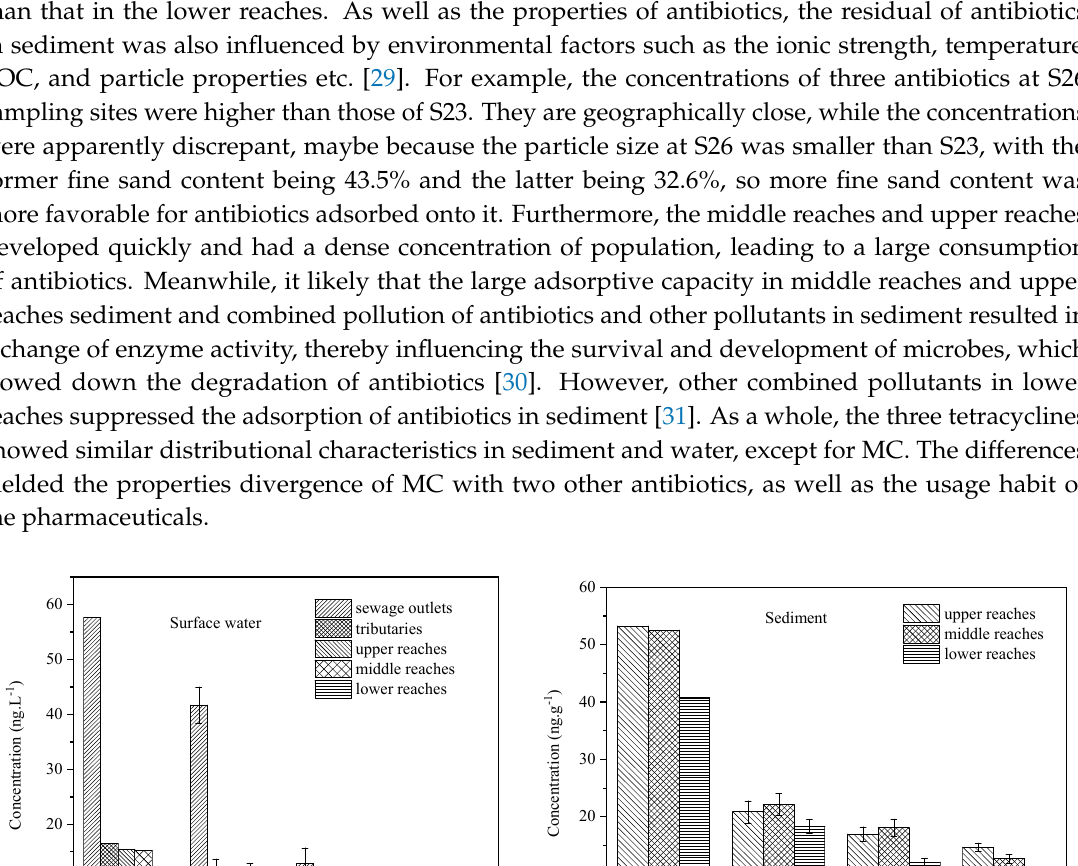
Table 3. Toxicity data of antibiotics corresponding to sensitive species.